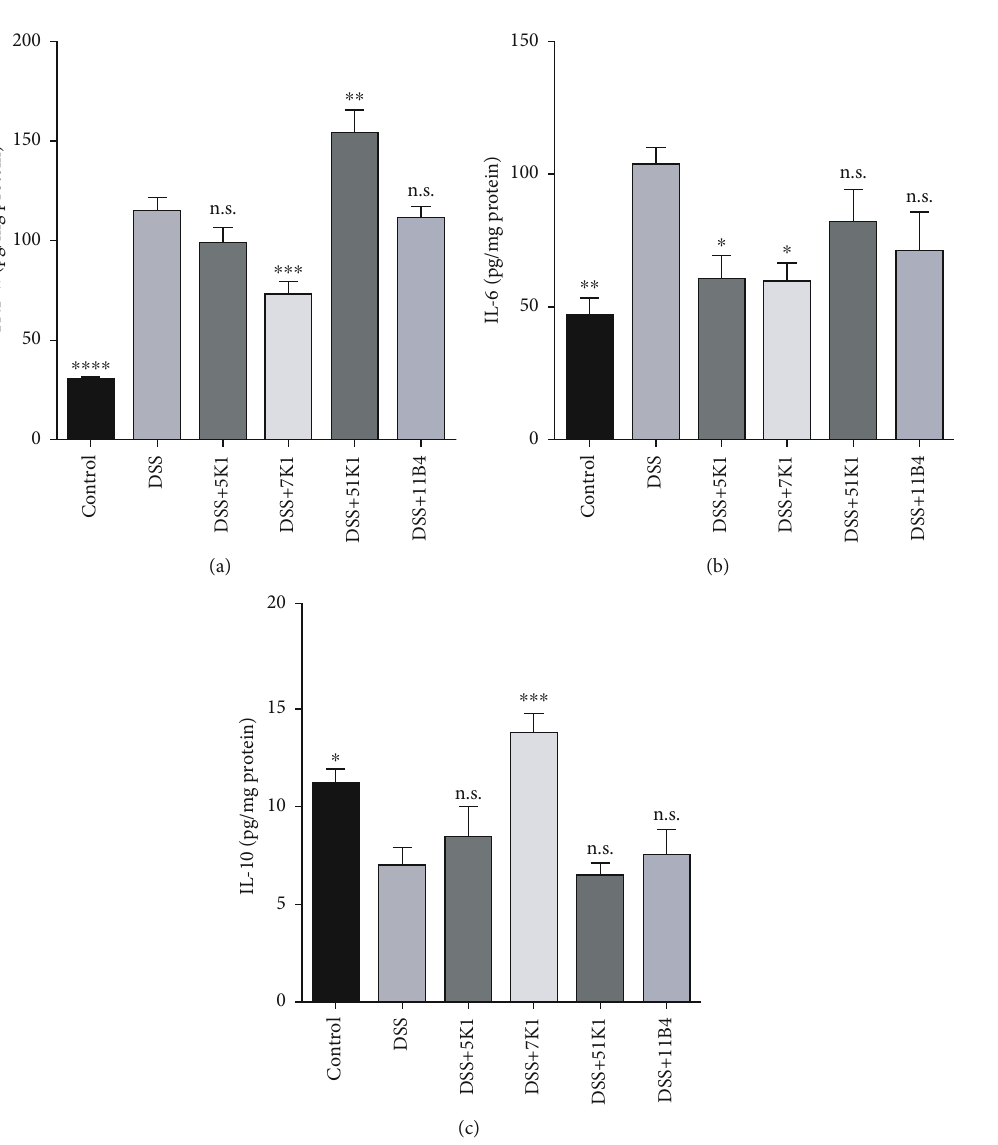
Figure 5: E ff ects of Bacteroides vulgatus on the concentrations of in fl ammatory cytokines. (a) TNF- α . (b) IL-6. (c) IL-10. Six mice per